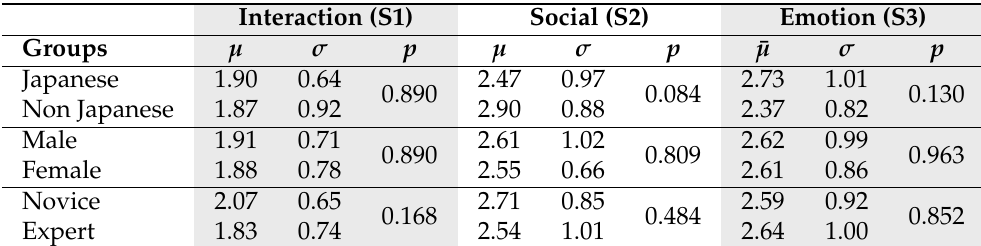
Table 6. Average ( µ ) and standard deviation ( σ ) of the NARS questionnaire according to each different group. The column p represents the p-value of Welch’s t -test. Because the NARS-S3 is using positive questions, it is the five’s complement of the mean that is